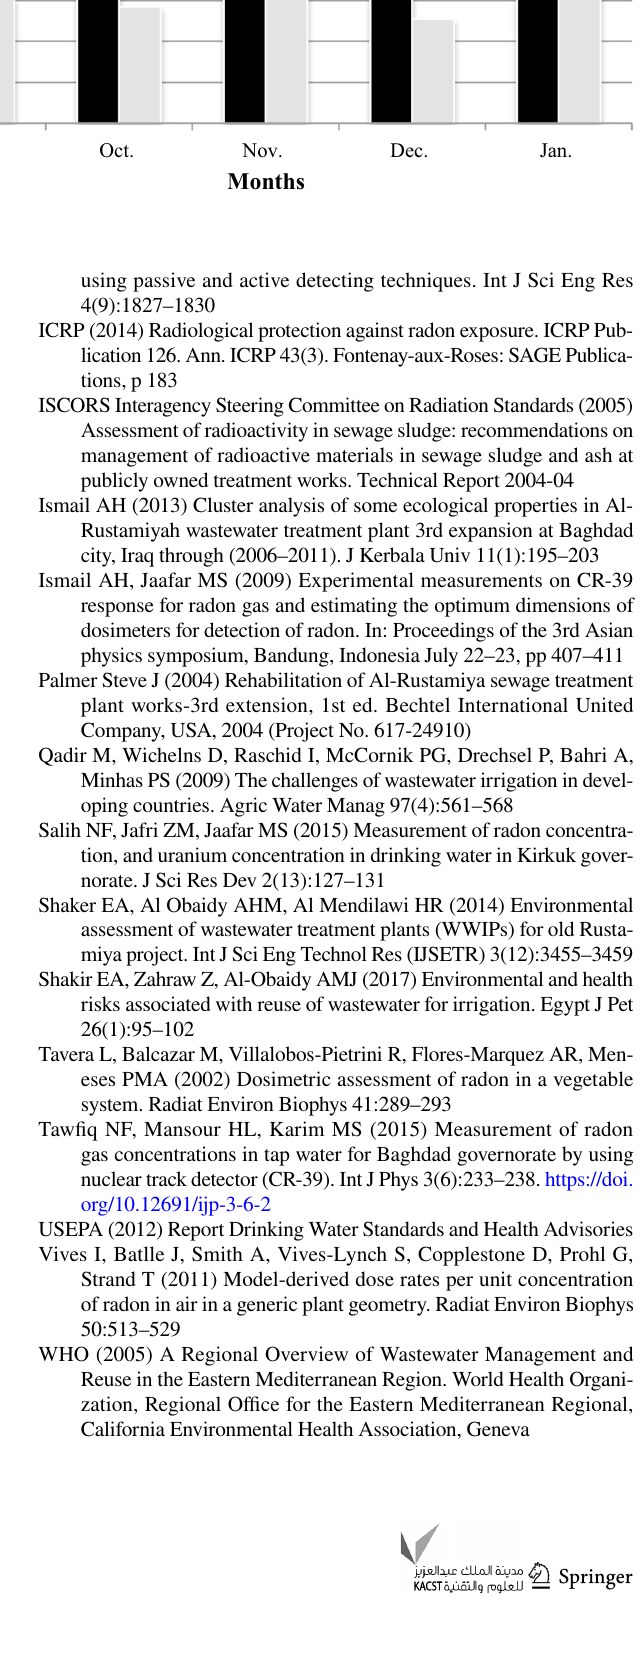
Fig. 5 Radon surface exhala- tion rate in wastewater samples before and after